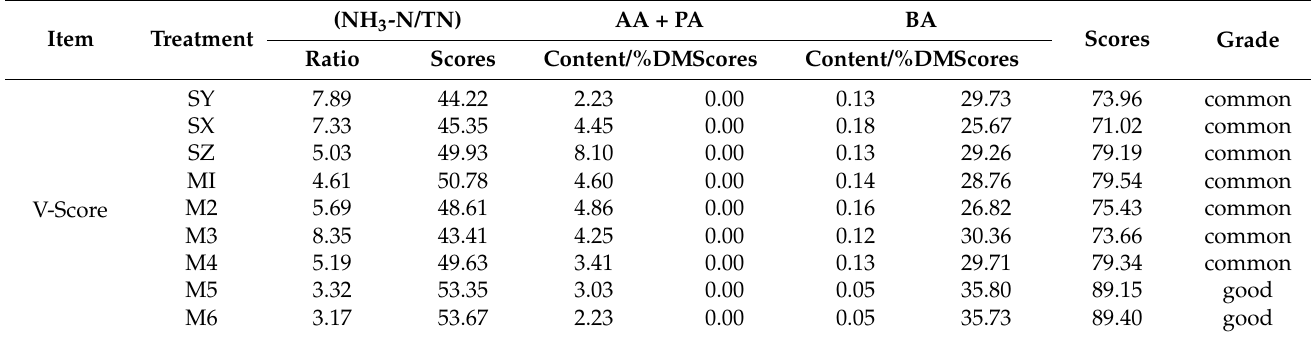
Table 7. Quality evaluation of the V-Score in different treatment